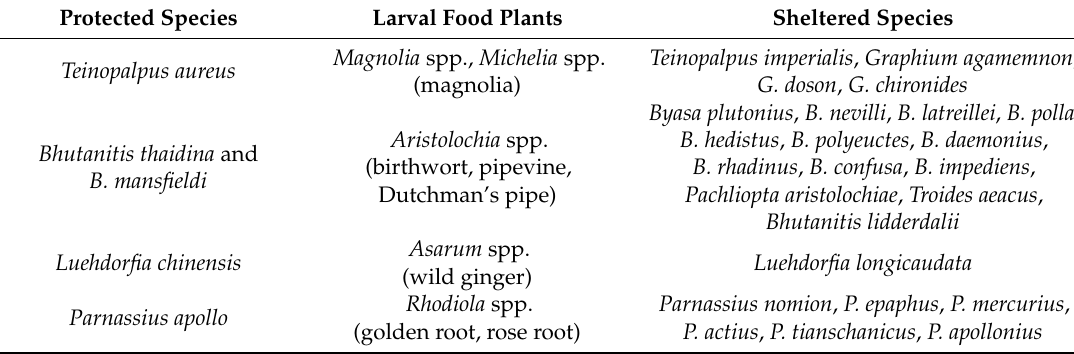
Table 1. Unprotected Papilionidae species sheltered under umbrella species (in the protected SSP List ) via sharing larval food